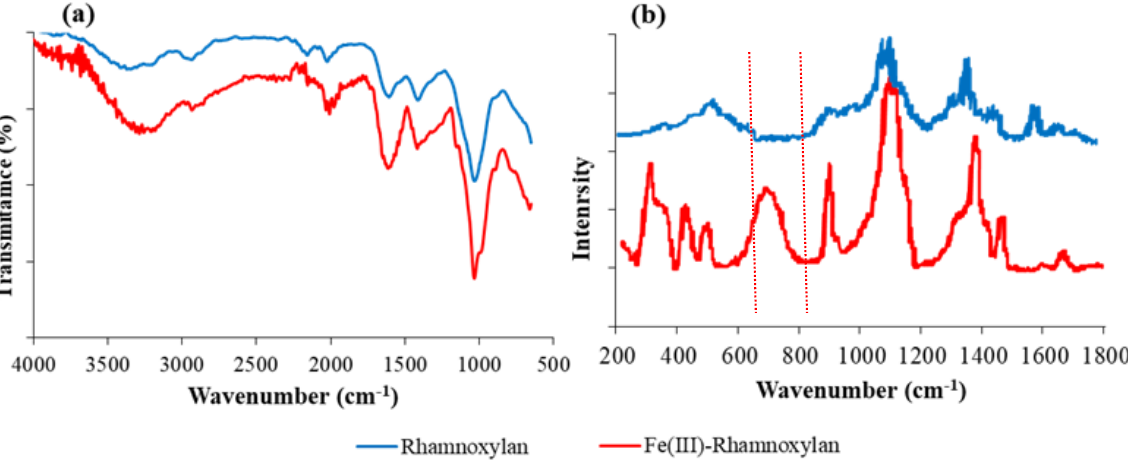
Figure 1. ( a ) FTIR and ( b ) Raman spectra of rhamnoxylan and Fe(III)–rhamnoxylan complex.